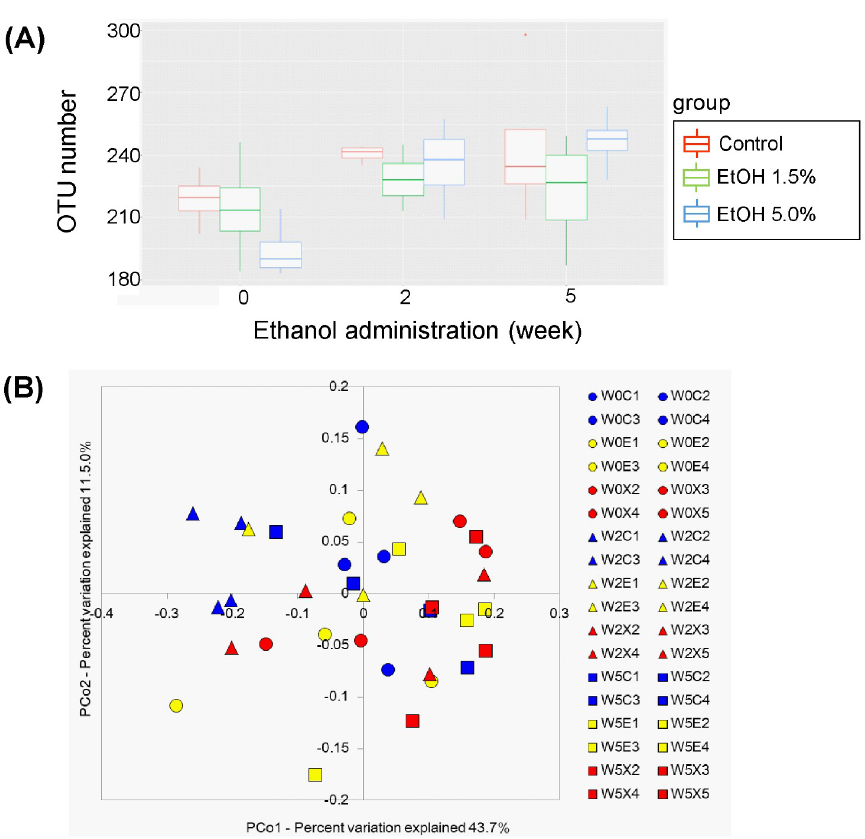
Fig 7. OTU analysis and UniFrac PCoA plots of fecal bacterial communities of the control (Con), 1.5%-ethanol, and 5.0%-ethanol groups. (A) OTU analysis. Box-whisker plots of fecal OTU numbers of the control (red), 1.5%- ethanol (blue), and 5.0%-ethanol (green) groups are shown. (B) UniFrac PCoA plots. The red, blue, and green symbols denote the control (Con), the 1.5%-ethanol, and the 5.0%-ethanol groups, respectively. Circle, triangle, and square symbols denote 0 weeks, 2 weeks, and 5 weeks, respectively, of chronic ethanol administration. For subject names, “W0C1”, for example, refers to mouse #1 of control group (C) at week 0 (W0), “W2E3” refers to mouse #3 of the 1.5% ethanol group (E) at week 2 (W2), and “W5X4” refers to mouse #4 of the 5.0% ethanol group (X) at week 5 (W5).